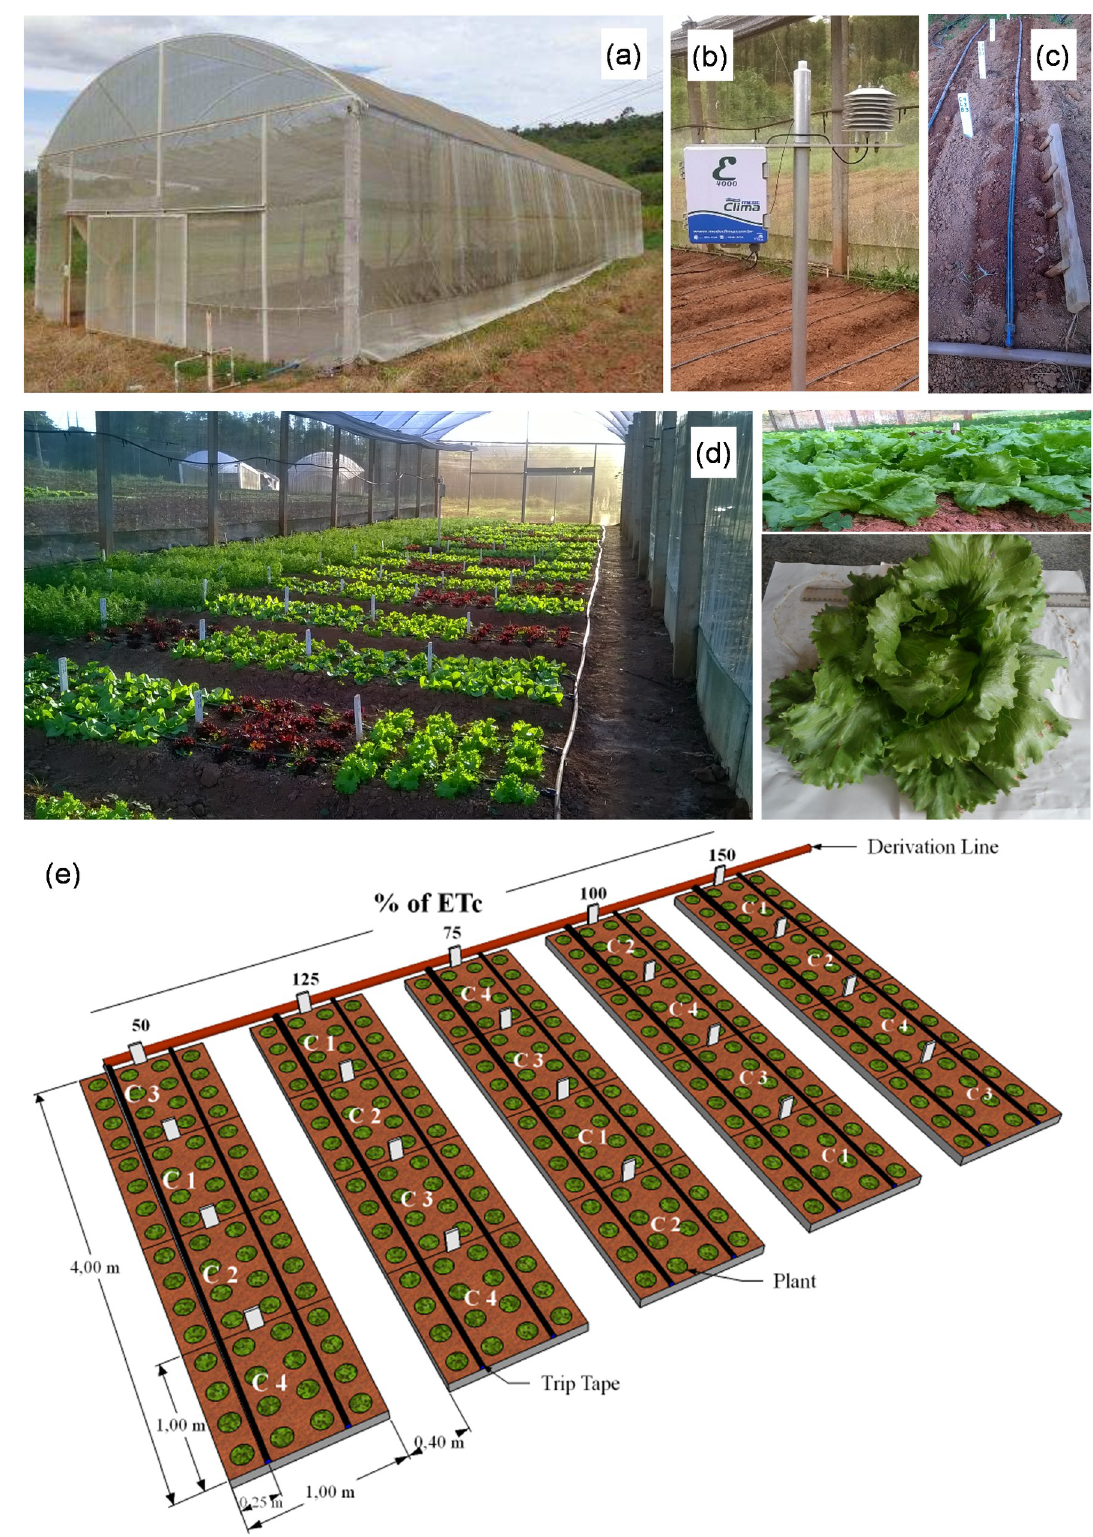
Fig 1. Research installation location (a, b, c and d) and structure of one of the four blocks (e). C: lettuce cultivars. Vic¸osa-MG, 2017.